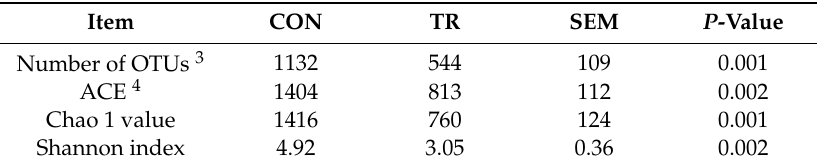
Table 4. Alpha diversity of ruminal bacterial communities of CON 1 and TR 2